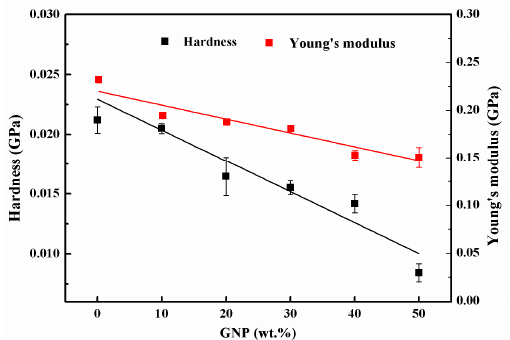
Figure 10. Hardness and Young’s modulus of hybrid films varied with the GNP weight percentages.